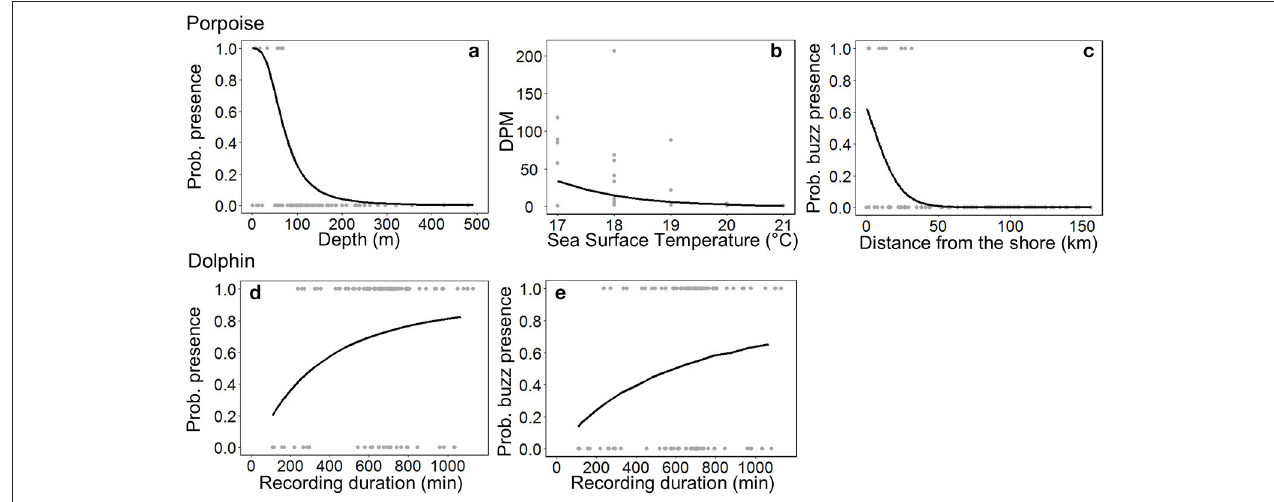
FIGURE 3 | Responses of small cetaceans to important variables included in models: (a) ocean floor depth on Burmeister’s porpoise Phocoena spinipinnis probability of presence, (b) sea surface temperature on porpoise time spent (detection positive minutes, DPM), (c) distance from the shore on the probability of porpoise buzzing activity, and the C-POD recording duration on the (d) probability of presence and (e) buzzing activity of dolphins (unspecified delphinids). For (a) the depth range is much greater (ca. 2,000m), but only depths up to 500m are plotted. Observed values are shown by gray dots, and the predicted relationship by a black